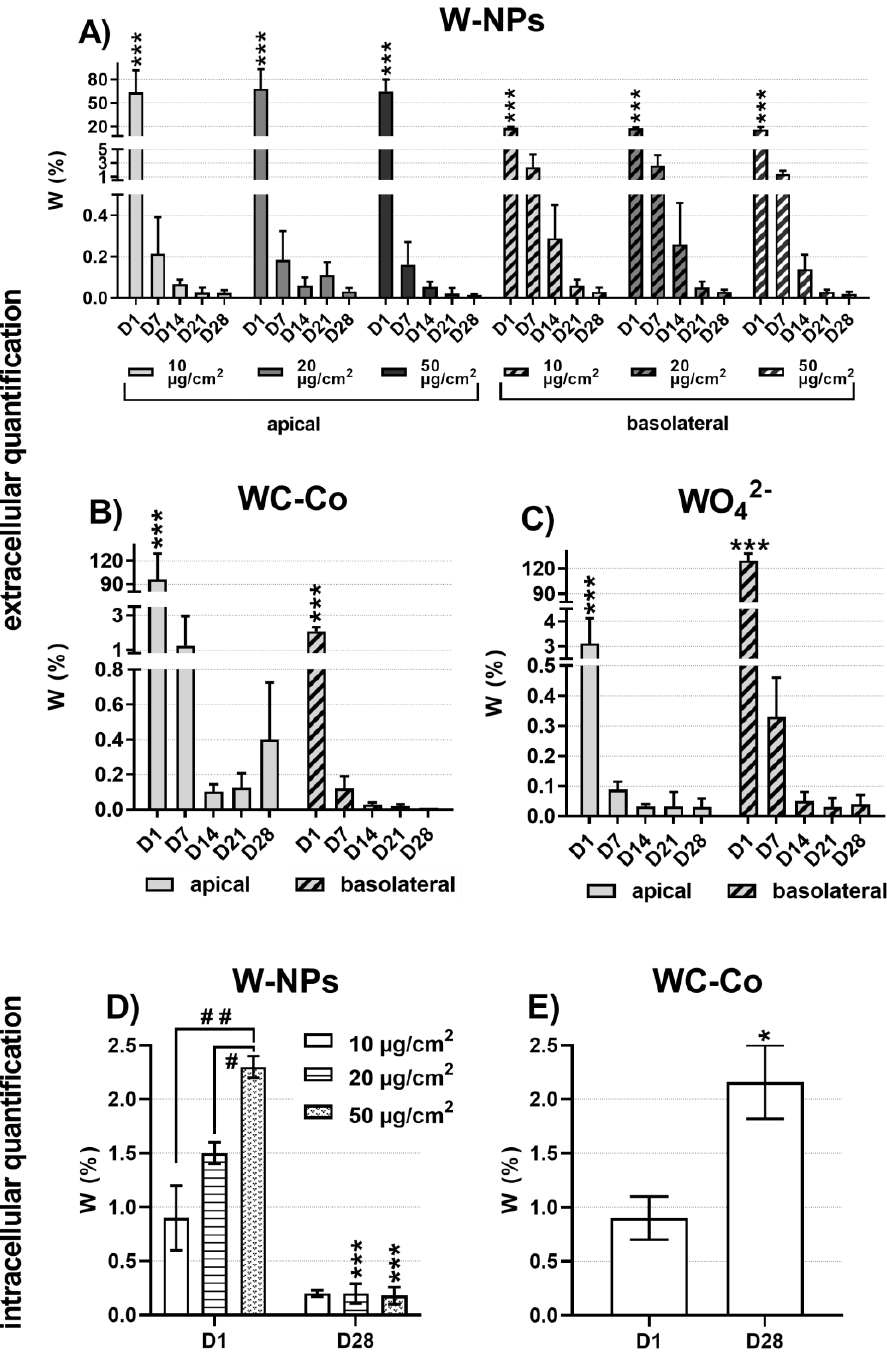
Figure 5. Transepithelial passage of W and cellular accumulation: extracellular quantification of ( A ) W-NPs, ( B ) WC-Co, ( C ) WO 42 − and intracellular quantification of ( D ) W-NPs, ( E ) WC-Co. W content was assessed in both apical and basal media of MucilAir™, as well as in cells, using inductively coupled plasma mass spectrometry (ICP-MS) after mineralization of the samples. The results are expressed as W% in the exposure solution ± SD at the end of the 24 h treatment (day 1), and at day 7, 14, 21 and 28 post exposure. Statistically significant differences from C neg were determined by a one-way ANOVA followed by Dunnett’s multiple comparisons test: * p < 0.05 and *** p < 0.001.